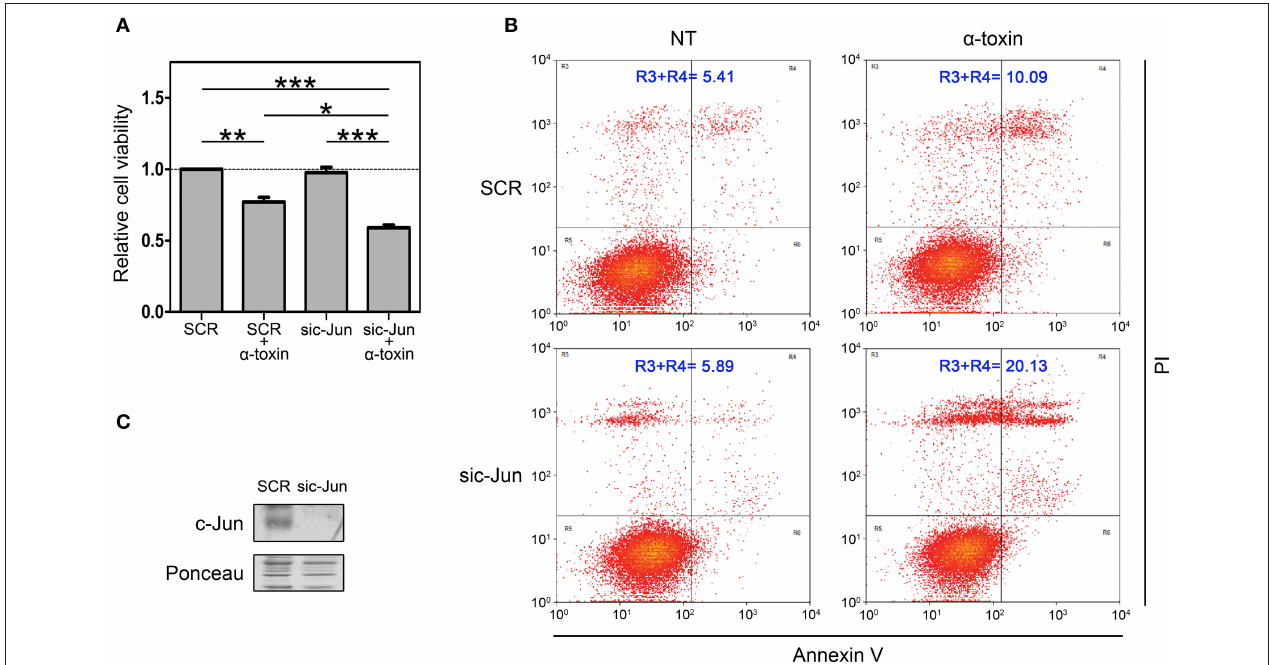
FIGURE 4 | Role of c-Jun in the viability of cells treated with α -toxin. (A) Dehydrogenase activity assays: A549 cells with normal (SCR) or knockdown (sic-Jun) levels of c-Jun were exposed to α -toxin (5 µ g ml-1) for 4h or left untreated. Cell viability was measured after incubation for 2h with a combined MTS/PMS solution by reading absorbance at 490nm with a microplate reader (Bio-Rad, Hercules, CA, USA). Viability was calculated from the absorbance ratio between values obtained at the end point with respect to those measured in SCR untreated cells. Measurements were carried out in triplicate for 4 independent experiments, and the results are expressed as means with their SEM. Statistically significant differences at P < 0.001, P < 0.01, and P < 0.05 are identified by ***, **, and *, respectively (one-way ANOVA followed by Dunnet’s post hoc test). (B) Flow-cytometry analyses: A549 cells with normal (SCR) or knockdown (sic-Jun) levels of c-Jun were exposed to α -toxin (5 µ g ml-1) for 4h or left untreated. Subsequently, cells were double stained with propidium iodide and the fluorescence-labeled annexin V followed by flow cytometric analyses to quantify cell death. One representative experiment of two is shown. (C) Knockdown of c-Jun was carried out using 25nM of siRNA for c-Jun, using SignalSilence ® Control siRNA (SCR) for controls. A representative Western Blot performed with specific antibodies against c-Jun is shown. Ponceau staining of total transferred proteins were used as loading